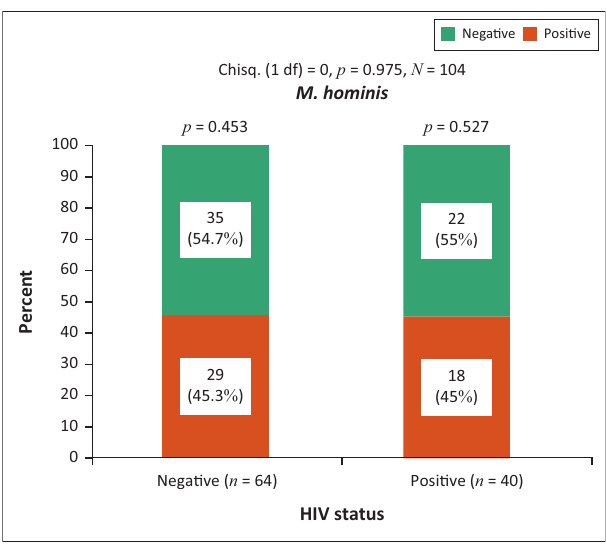
FIGURE 1: Prevalence of Mycoplasma hominis amongst HIV infected and uninfected